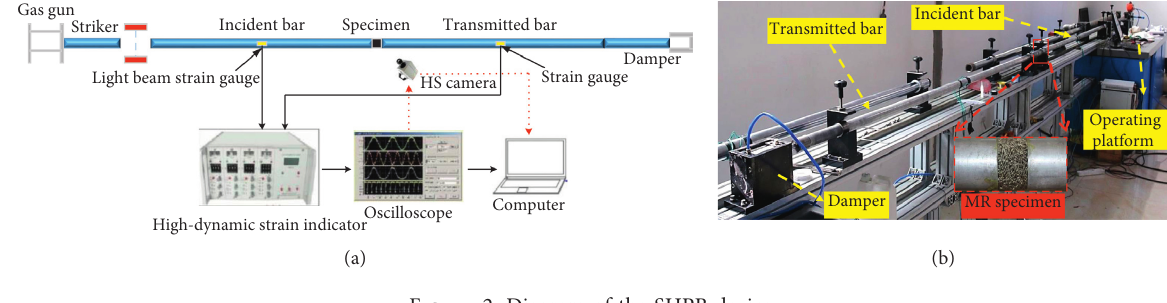
Figure 2: Diagram of the SHPB